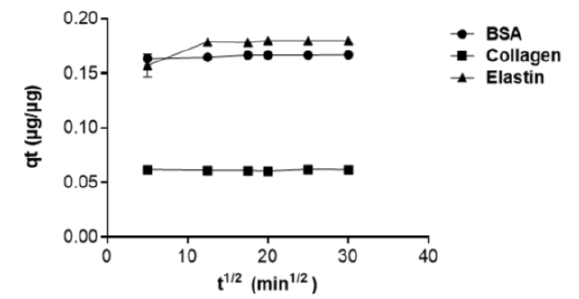
Figure 5. Intra-particle di ff usion model plot.